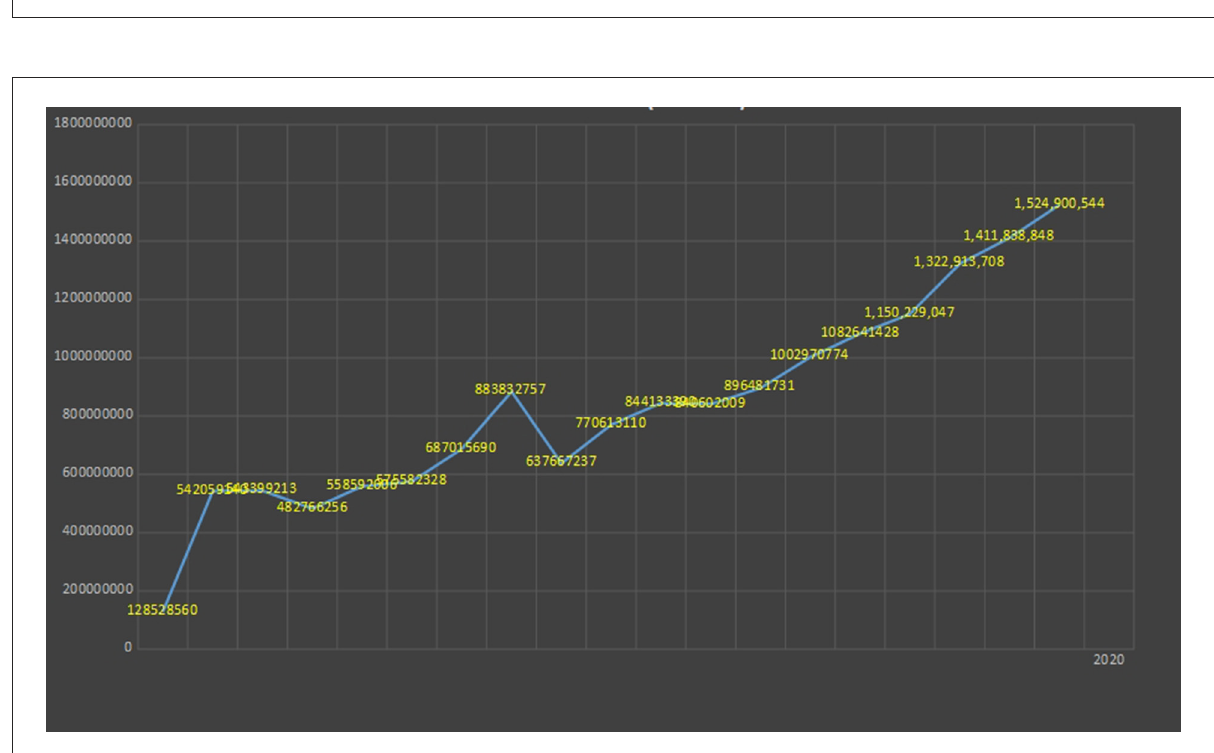
FIGURE11 Total net assets of environmental NGOs listed in Figures 8, 9. Year.